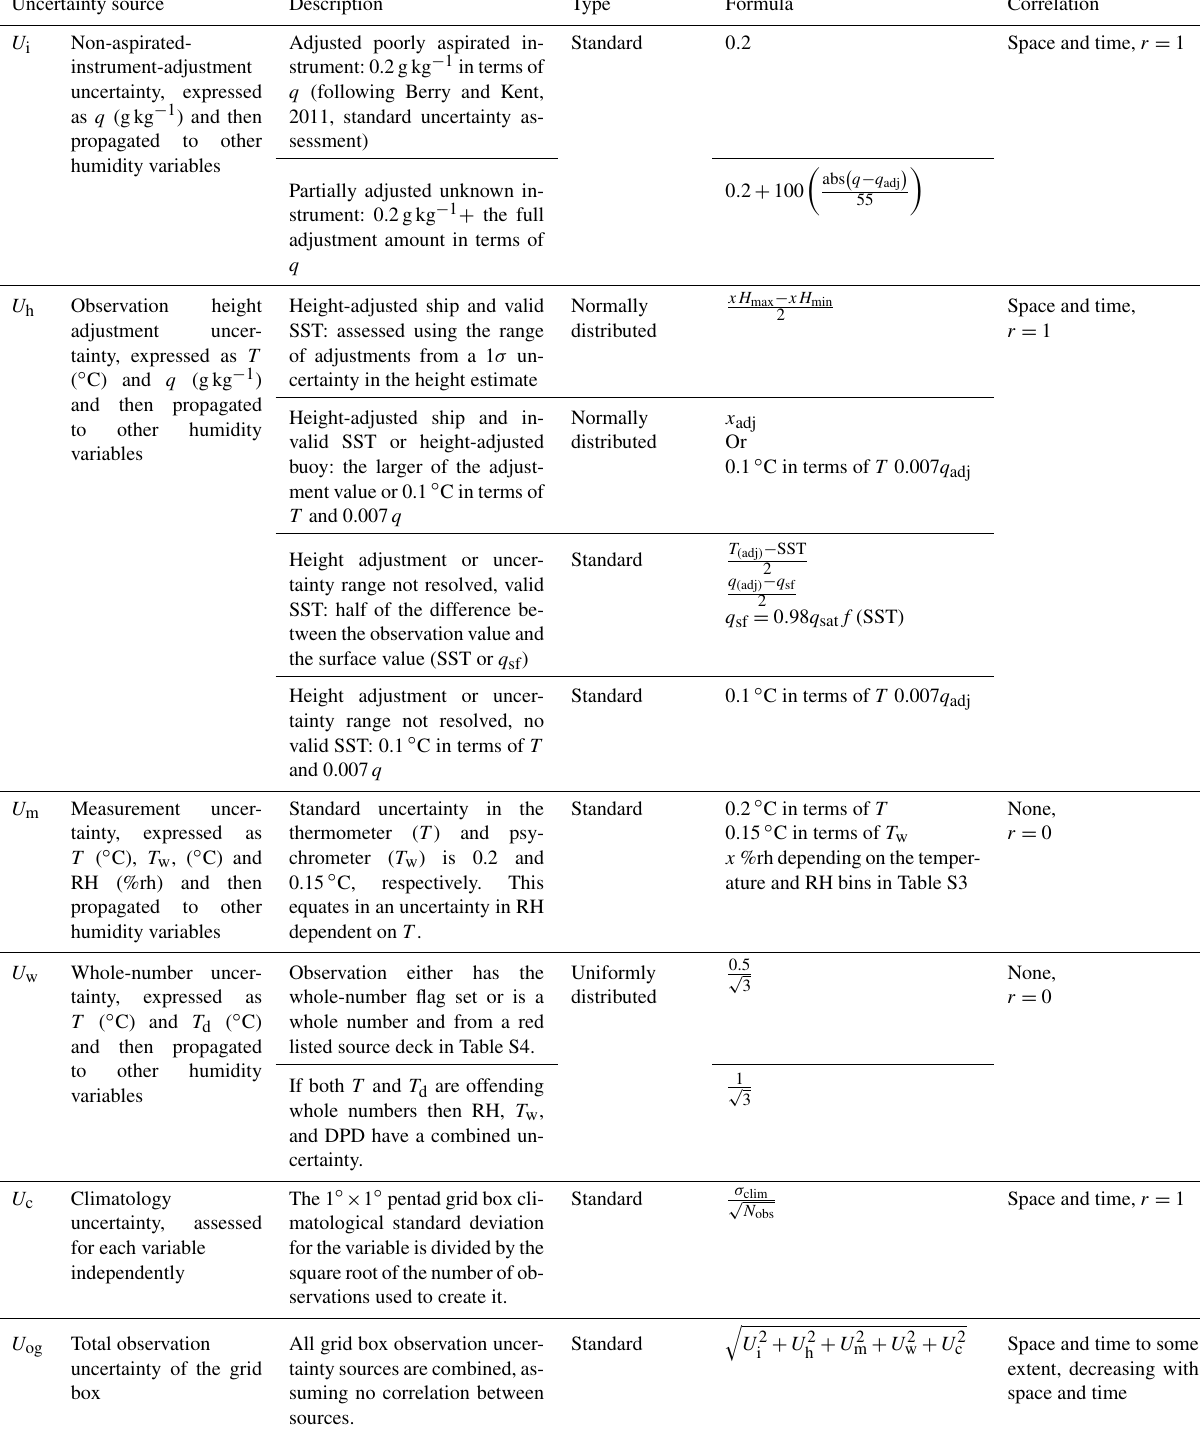
Table 2. Description of the uncertainty elements affecting marine humidity. All uncertainties are assessed as 1 σ uncertainty. Uncertainty source Description Type Formula